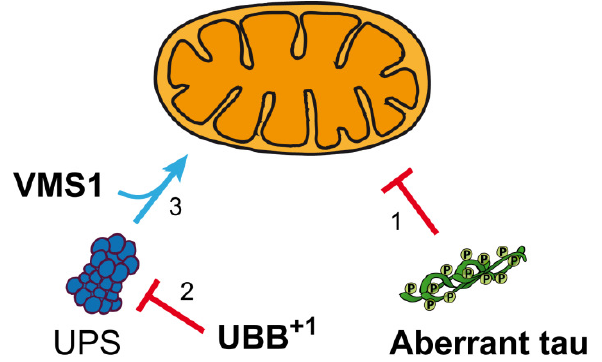
FIGURE 1: Hypothetical model for preventing AD-associated mitochondrial dysfunction triggered by the accumulation of UBB +1 and aberrant tau. Hyperphosphorylated forms of the mi- crotubule-associated protein tau interfere with mitochondrial function (1). In parallel, the cellular accumulation of UBB +1 induces UPS dysfunction (2) thereby indirectly impairing mitochondria. The mitochondrion-associated UPS, which depends on VMS1, ensures the local protein quality at mitochondria (3) and by this way protects from neuronal cell loss elicited by damaged mito-